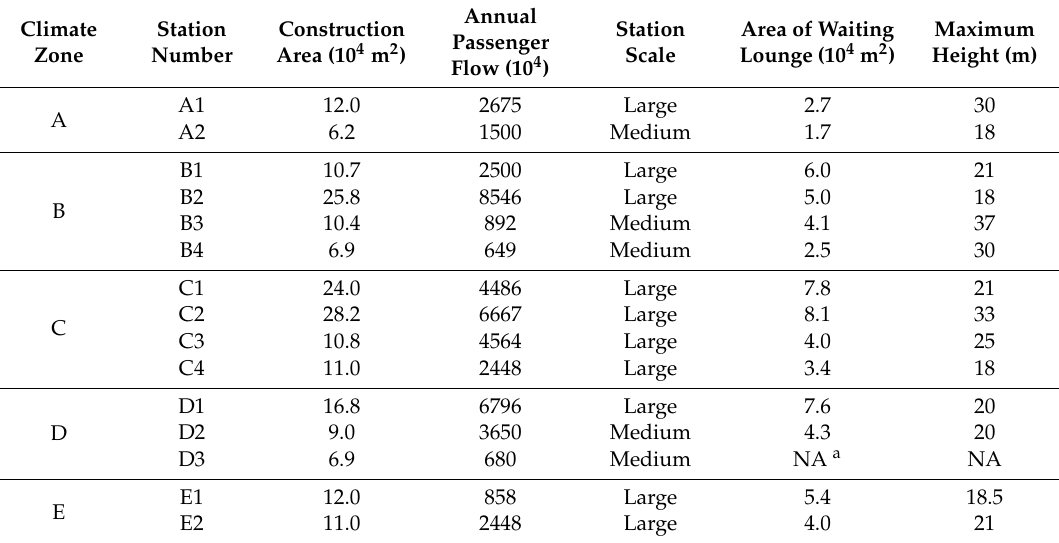
Table 1. General situation of stations.